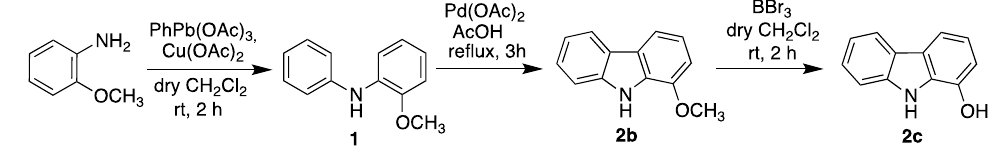
Figure 2. Synthesis of carbazole derivatives 2b and 2c.